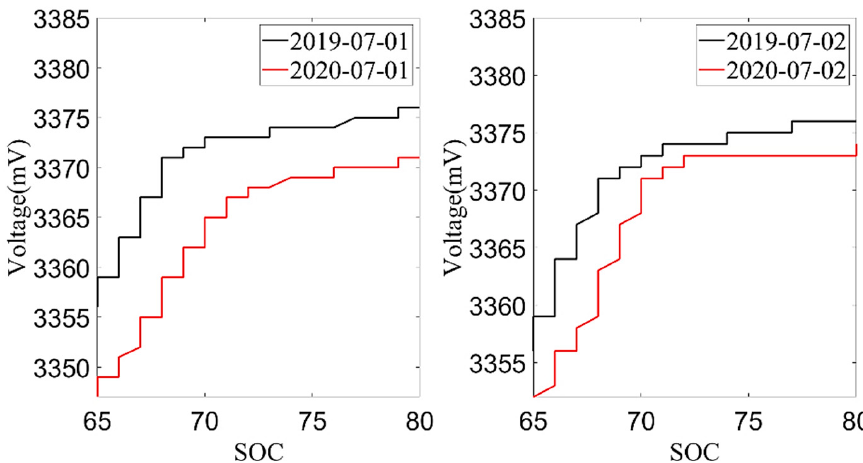
Sensors 2022 , 22 , x FOR PEER REVIEW Figure 8. The relationship between SOC and cell voltage. Figure 8. The relationship between SOC and cell voltage.